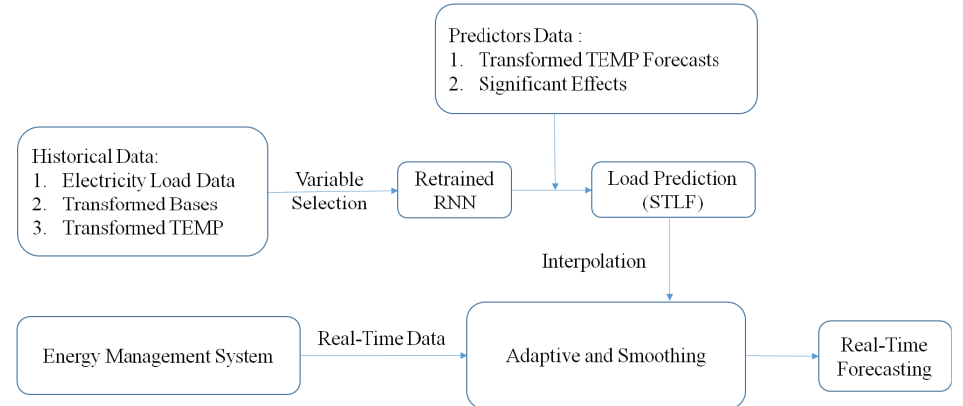
Figure 1. Proposed spline-bases assisted Recurrent Neural Network (RNN) for Short Term Load Forecasting (STLF) and RNN 𝑎𝑑𝑝 model.